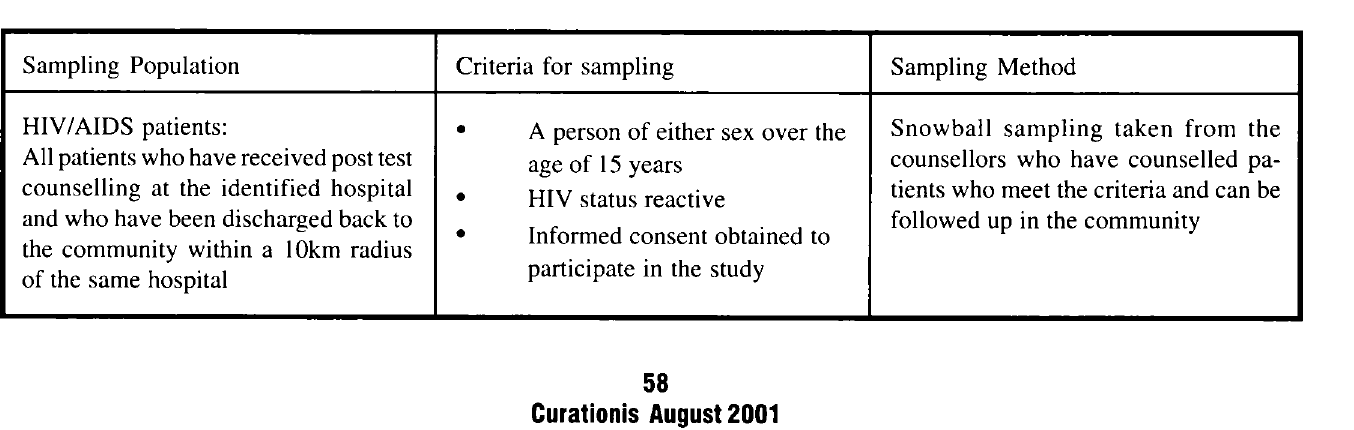
Sampling Population Criteria for